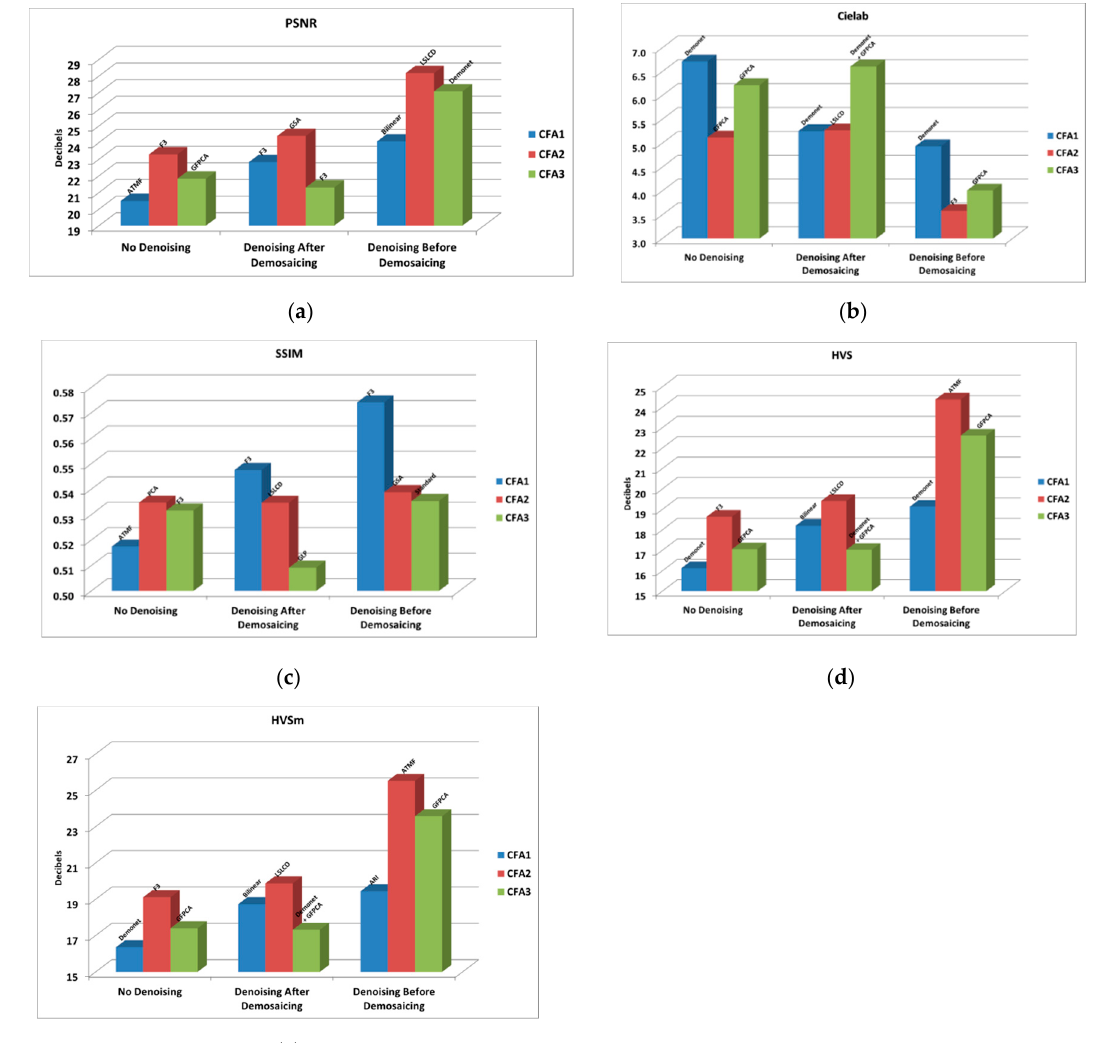
Figure 22. Best against the best comparison between CFAs 1.0, 2.0, and 3.0 with and without denoising at 20 dBs SNR. ( a ) PSNR metrics; ( b ) Cielab metrics; ( c ) SSIM metrics; ( d ) HVS metrics; ( e ) HVSm